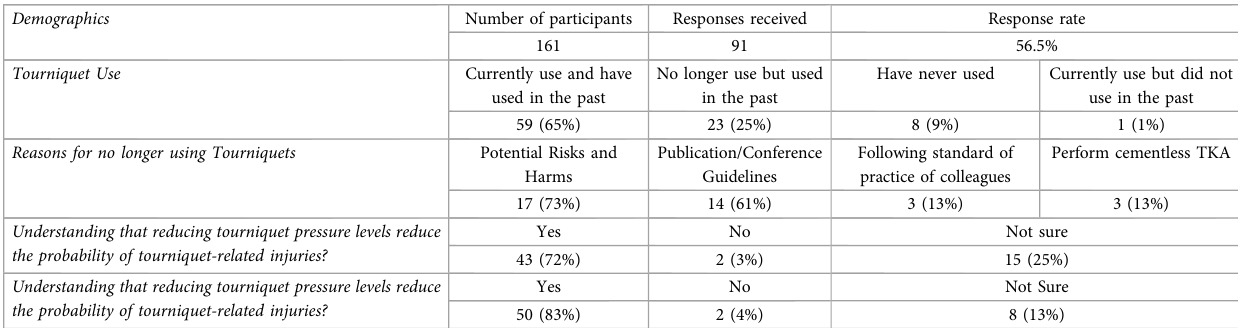
TABLE 1 Summary of survey